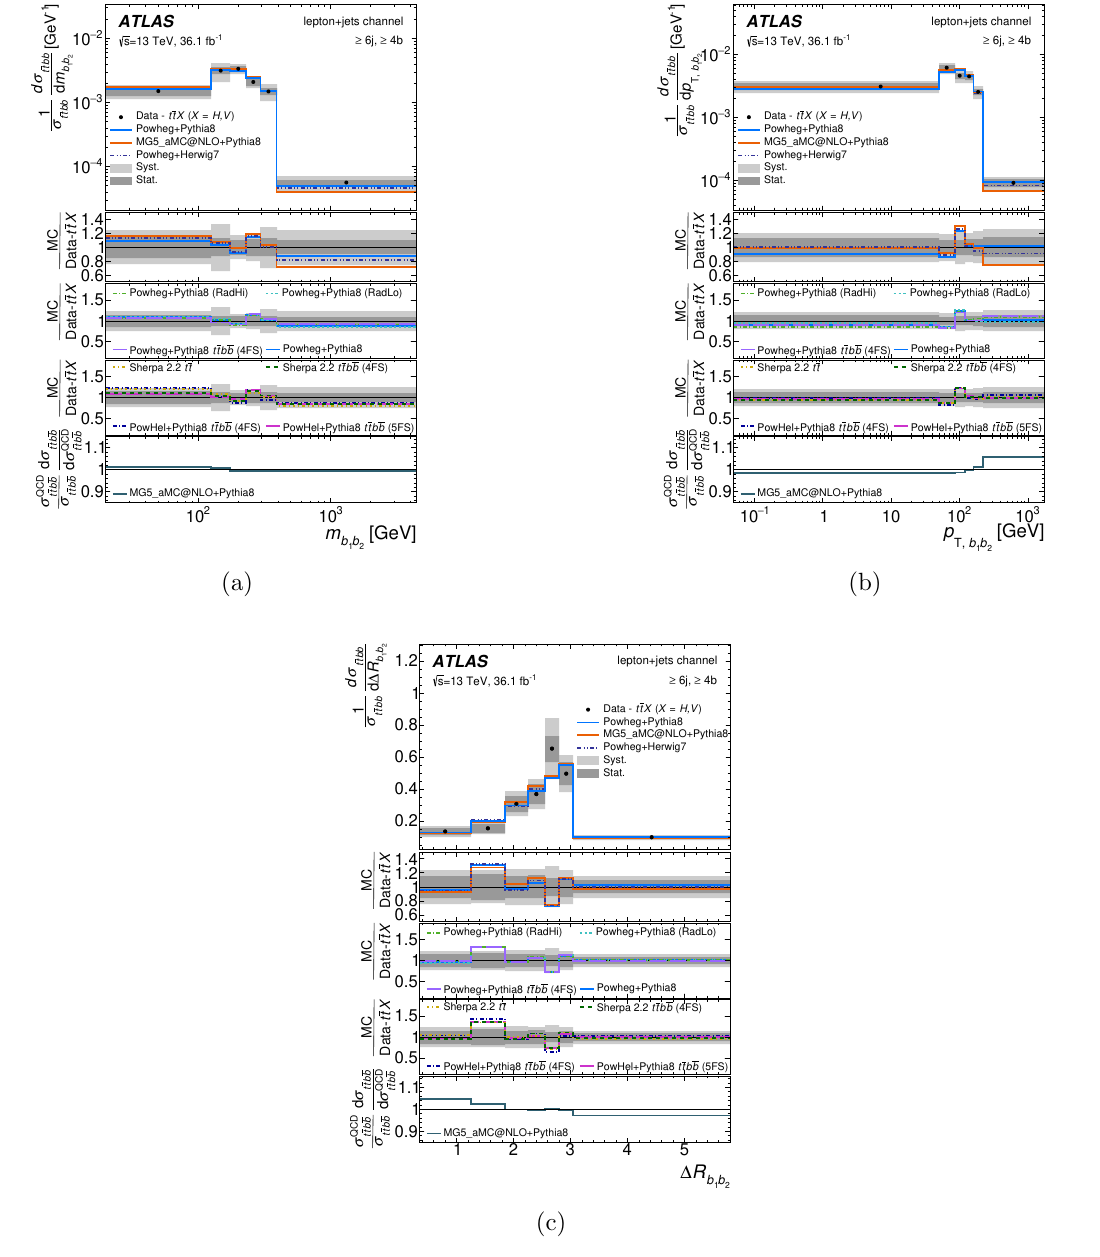
Figure 15. Relative di(cid:11)erential cross-sections as a function of (a) m b (cid:1) R b of the two highest- p T b -jets in events with at least four b -jets in the lepton + jets channel 1 ;b 2 compared with various MC generators. The t (cid:22) tH and t (cid:22) tV contributions are subtracted from data. Four ratio panels are shown, the (cid:12)rst three of which show the ratios of various predictions to data. The last panel shows the ratio of predictions of normalised di(cid:11)erential cross-sections from MadGraph5 aMC@NLO+ Pythia 8 including (numerator) and not including (denominator) the contributions from t (cid:22) tV and t (cid:22) tH production. Uncertainty bands represent the statistical and total systematic uncertainties as described in section 8. Events with observable values outside the axis range are not included in the